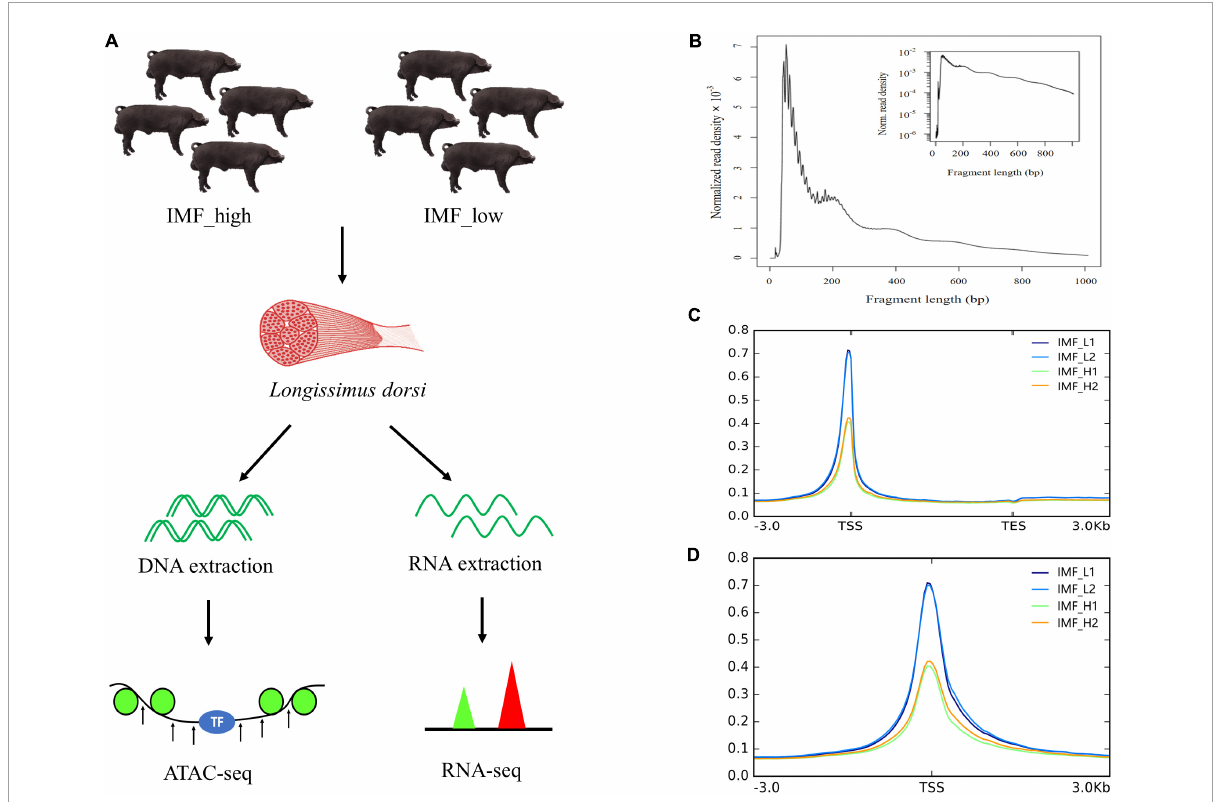
FIGURE1 Overview of the ATAC-seq results. (A) Schematic representation of the experiment. Longissimus dorsi from the two groups (IMF_high and IMF_low groups) were sampled, and then DNA and RNA were extracted and processed for ATAC-seq and RNA-seq, respectively. (B) Fragment length distribution map. (C,D) Mapped reads distributions across gene bodies and peaks.